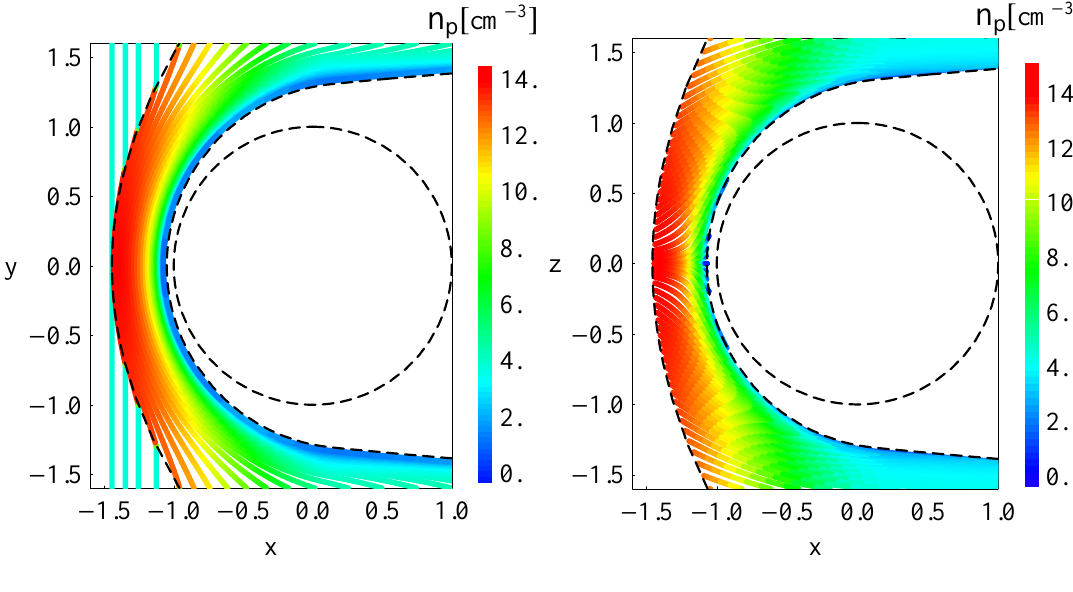
Fig. 7. MHD model: Distribution of the proton density in xy plane (left) and xz plane (right).